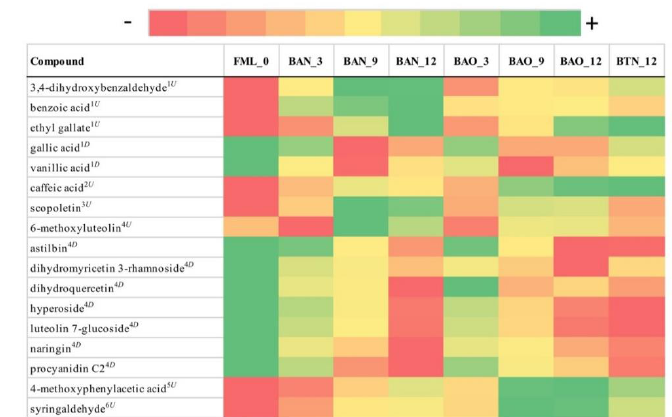
Figure 5. Color coded visualization of Table S4 included in the Supplementary Materials showing the metabolites detected by LC-MS with statistical and practical significance, for cellar ICVV. Numbers at the end of the sample acronyms represent the sampling month. The color gradient was individualized for each metabolite. Additionally, the numeric values represented the area of the detected chromatographic peaks after applying variance stabilization (Table S4). The metabolites can be grouped in the following chemical classes: (1) benzene and substituted derivatives, (2) cinnamic acids and derivatives, (3) coumarins and derivatives, (4) flavonoids, (5) phenol ethers, and (6) phenols. Metabolites that exhibited increasing tendency are indicated as superscript (U) and those with decreasing tendency as superscript (D).